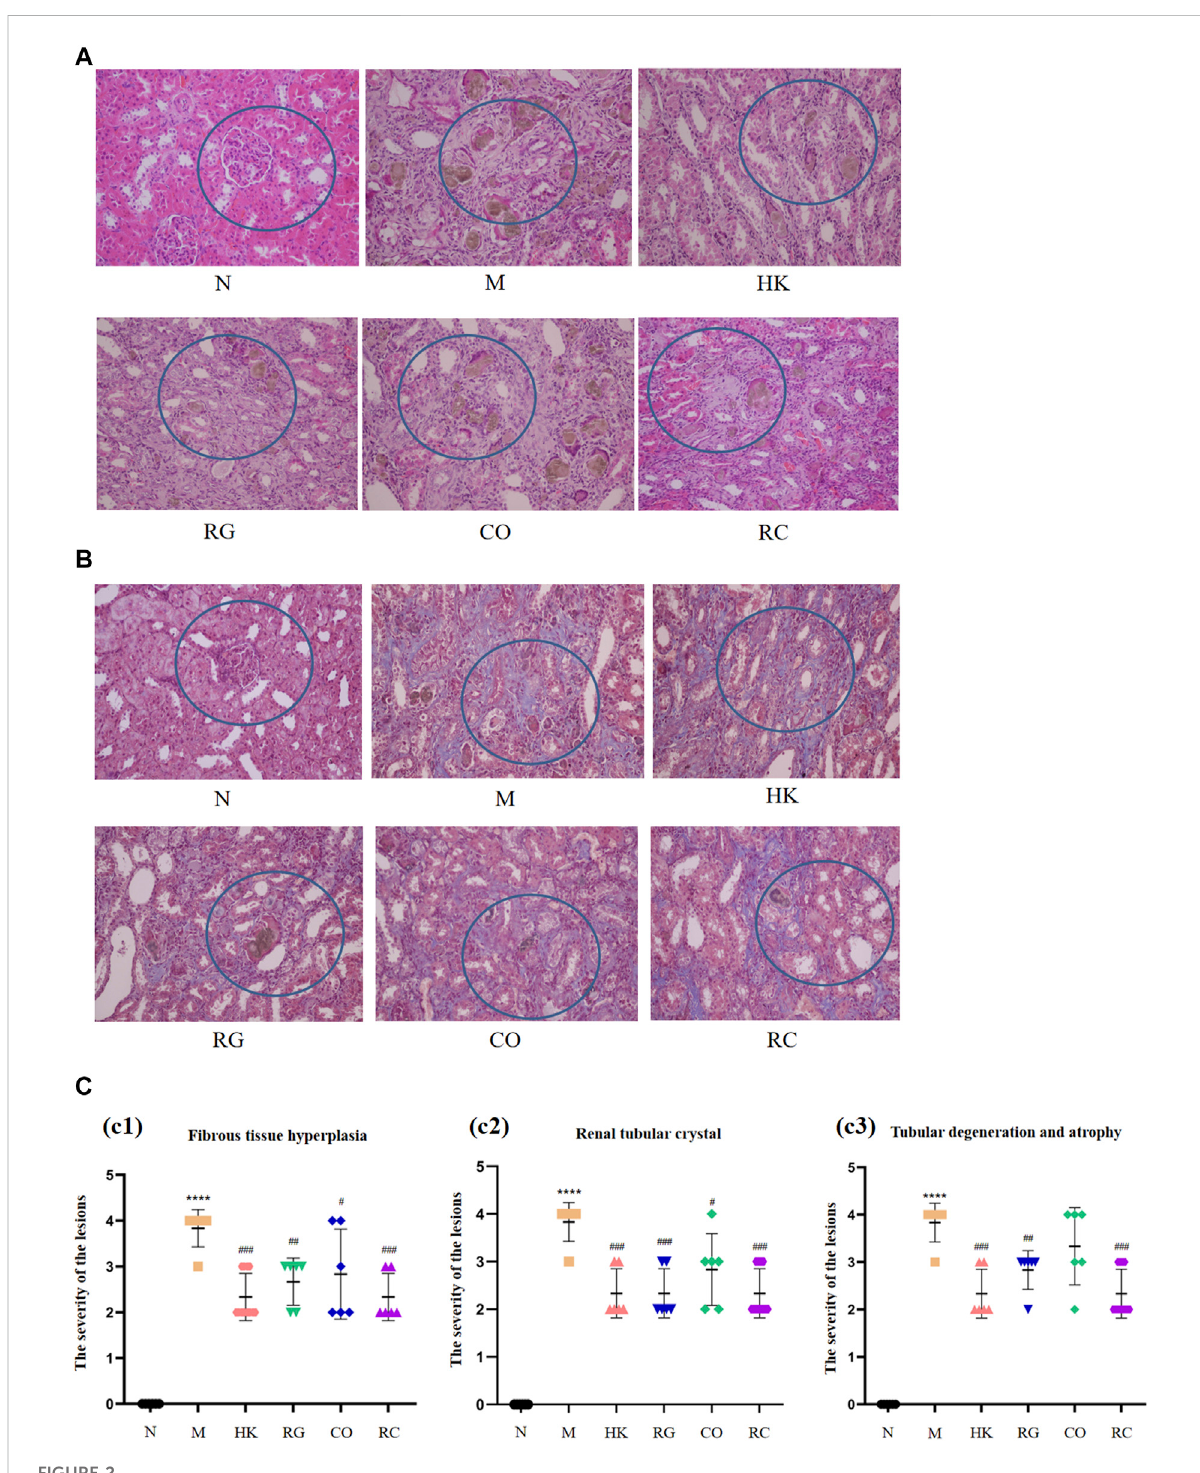
FIGURE 2 Routinehistopathological examinationandcollagendeposition ofthekidneysofratsfromdifferentgroupswereevaluatedbydifferentstaining methods. (A) H&E staining of the kidney of rats. (B) Masson staining of the kidney of rats. (C) Histological scoring was obtained from the H&E and Masson staining results of the kidney (c1) Fibrous tissue hyperplasia, (c2) Renal tubular crystal, (c3) Tubular degeneration and atrophy. (Data